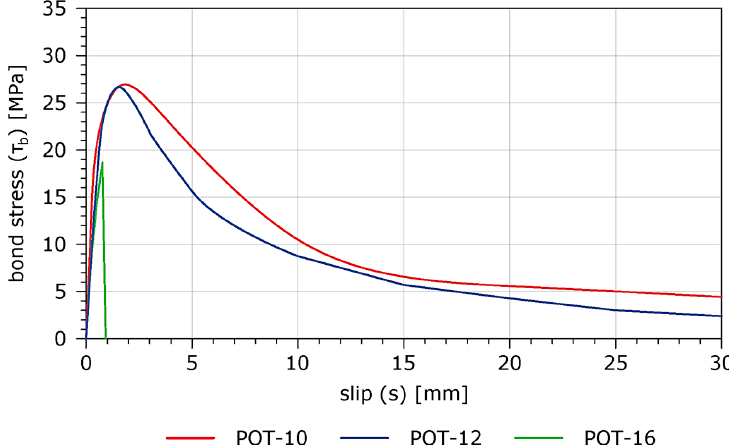
Figure 14. Comparison of representative curves obtained from pull-out tests.